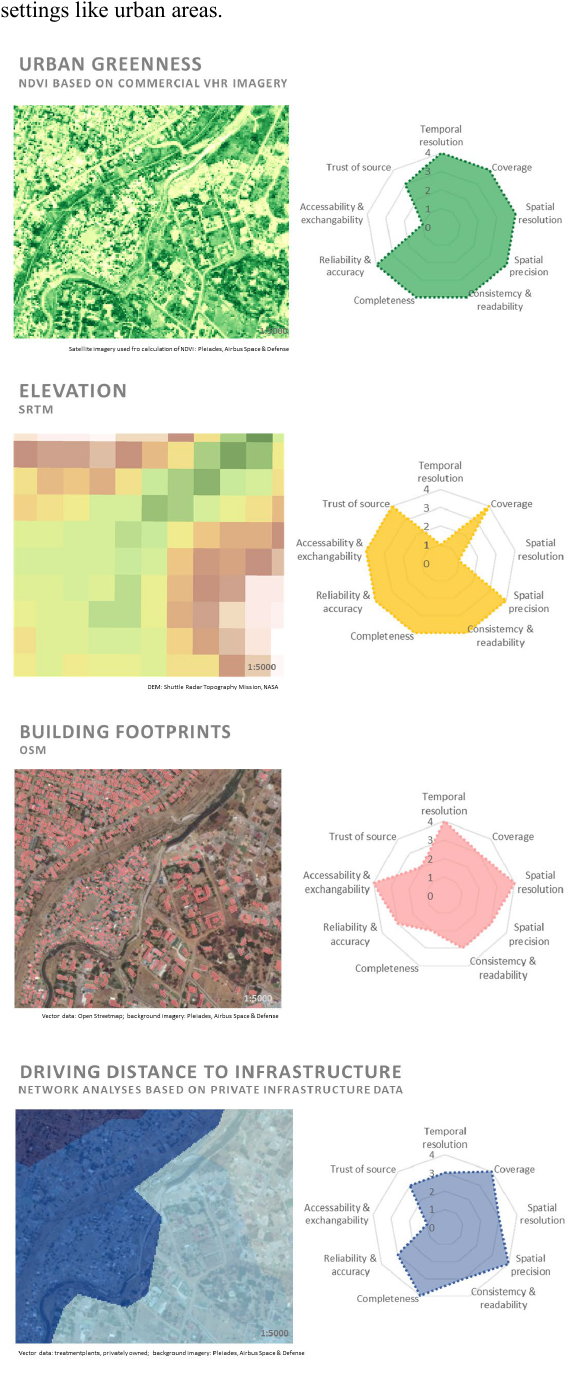
Figure 4. Heterogeneous geospatial data sets for an integrated assessment of the city structure in Lusaka, Zambia